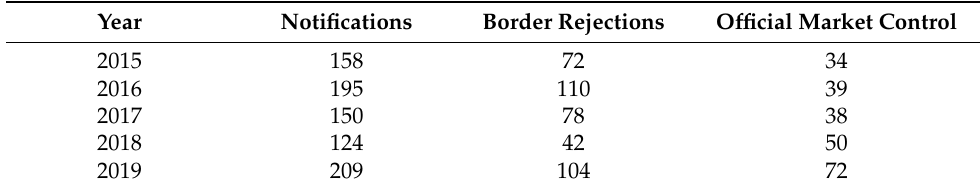
Table 1. Number of notifications of pollutants in herbs and spices in the EU Rapid Alert System for Food and Feed (RASFF) in 2015–2019 based on the RASFF-EC-Notifications